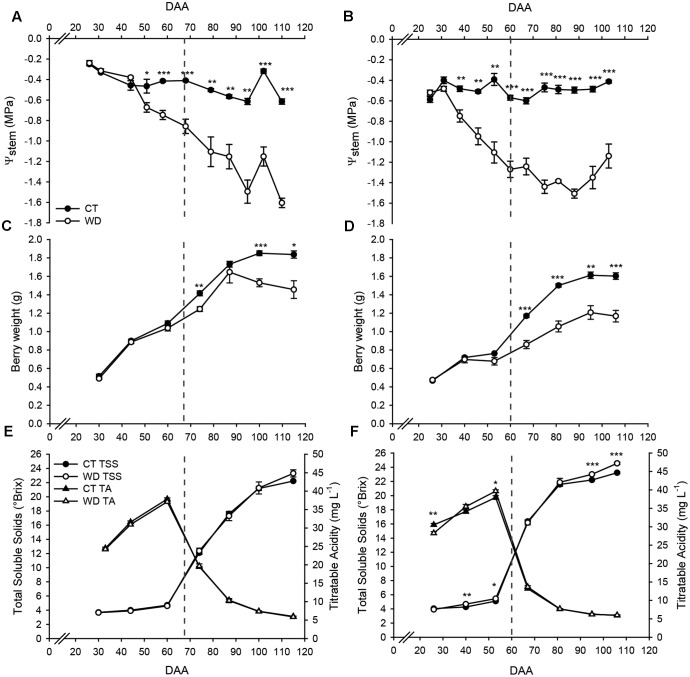
Stem water potential and physiological parameters of control (CT) and minimally irrigated (WD) vines and grapes in 2011 (left panels) and 2012 (right panels). (A,B) Stem water potential (ΨStem), (C,D) berry weight, (E,F) total soluble solids and titratable acidity. Dashed line indicates the onset of ripening (veraison). Bars represent ± SE. Asterisks indicate significant differences between treatments at P < 0.05 (∗), P < 0.01 (∗∗), P < 0.001 (∗∗∗) evaluated by one-way ANOVA.